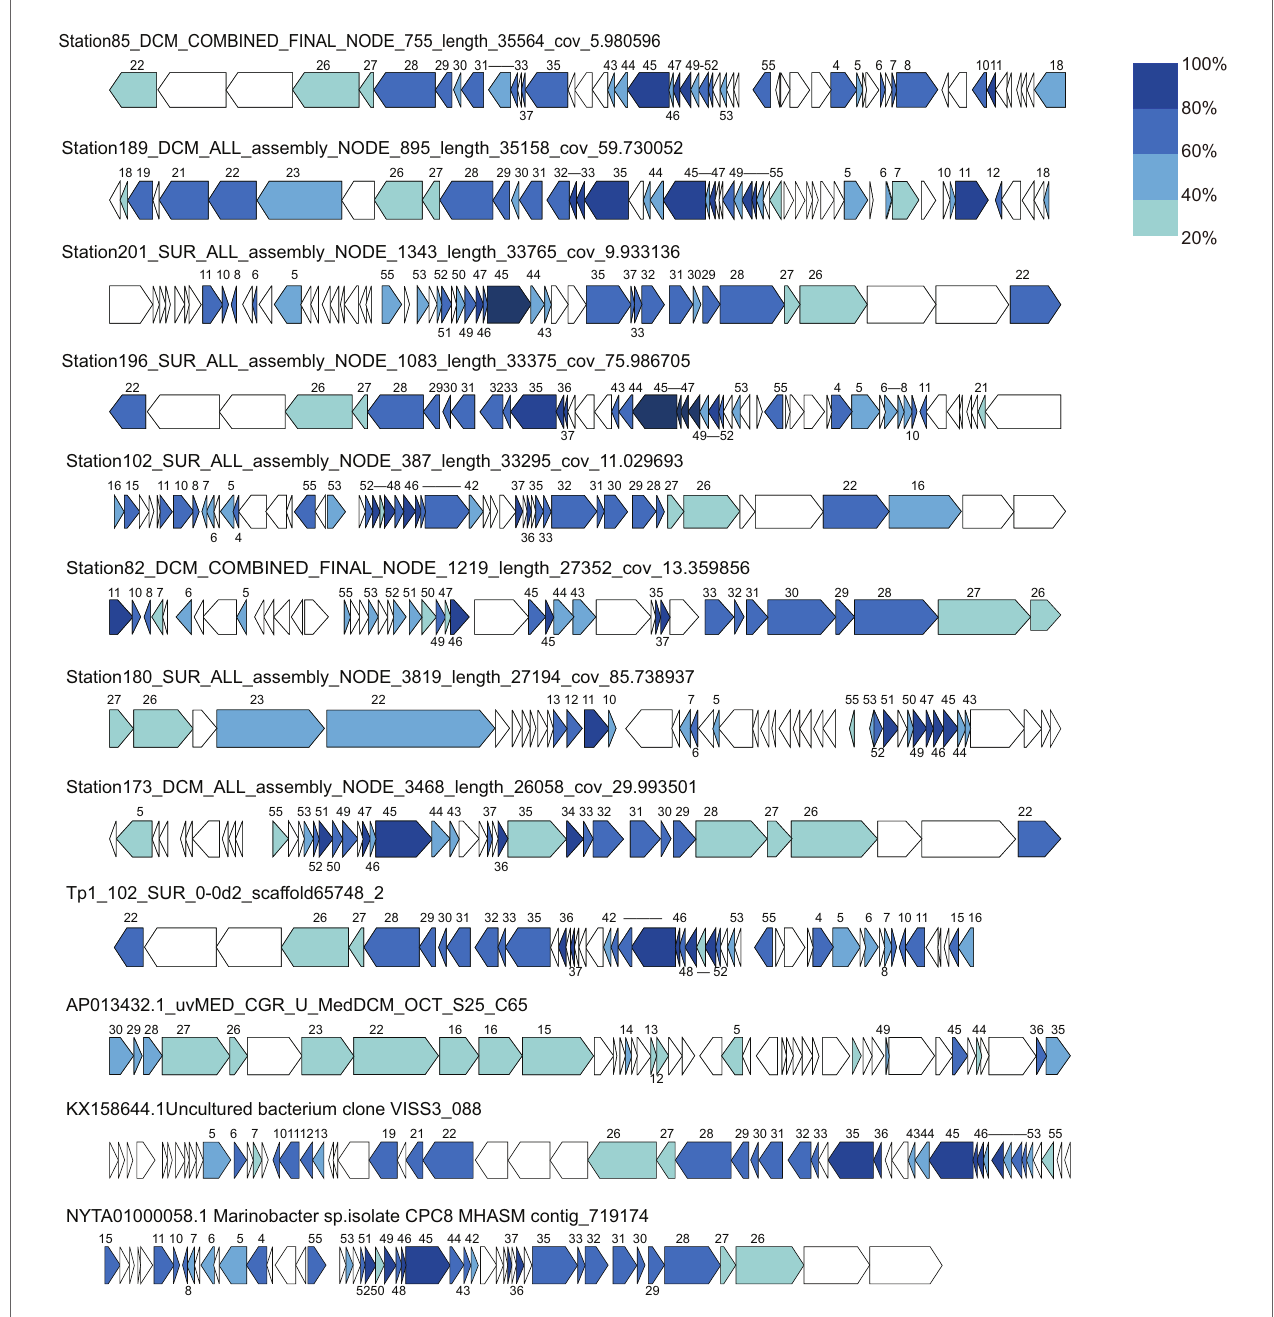
FIGURE 2 | Genome organization of 12 metagenomic viral genomes (MVGs) related to MEP301. Open reading frames (ORFs) are colored according to the degree of amino acid sequence identity to the genes in MEP301. The number of MEP301 homologous ORFs are indicated above the